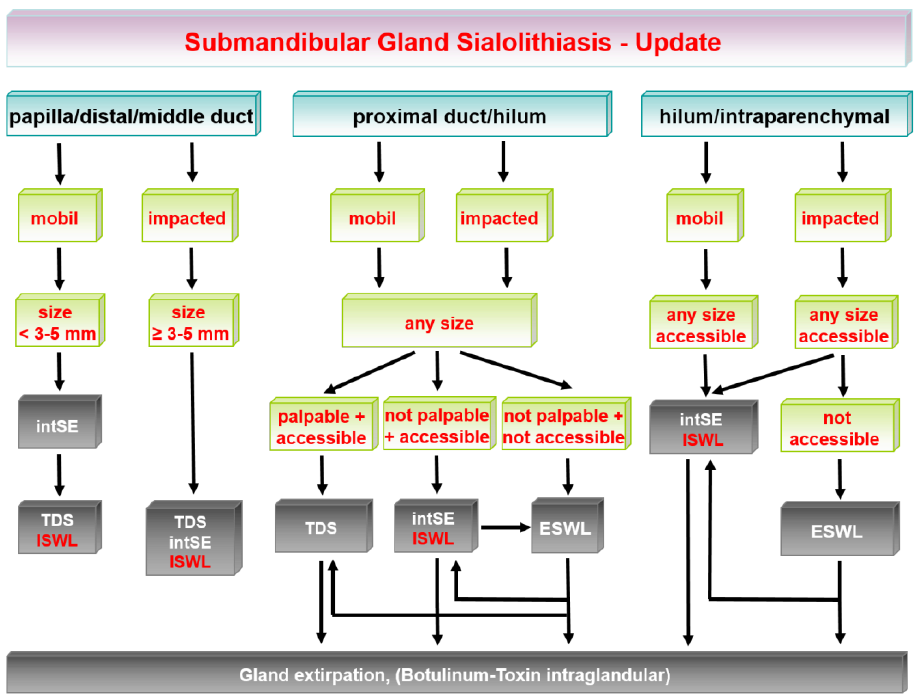
Figure 2. Submandibular gland sialolithiasis: current/updated treatment algorithms. ESWL, extra- corporeal shock-wave lithotripsy; intSE, interventional sialendoscopy; ISWL, intraductal shock-wave lithotripsy; TDS, transoral.